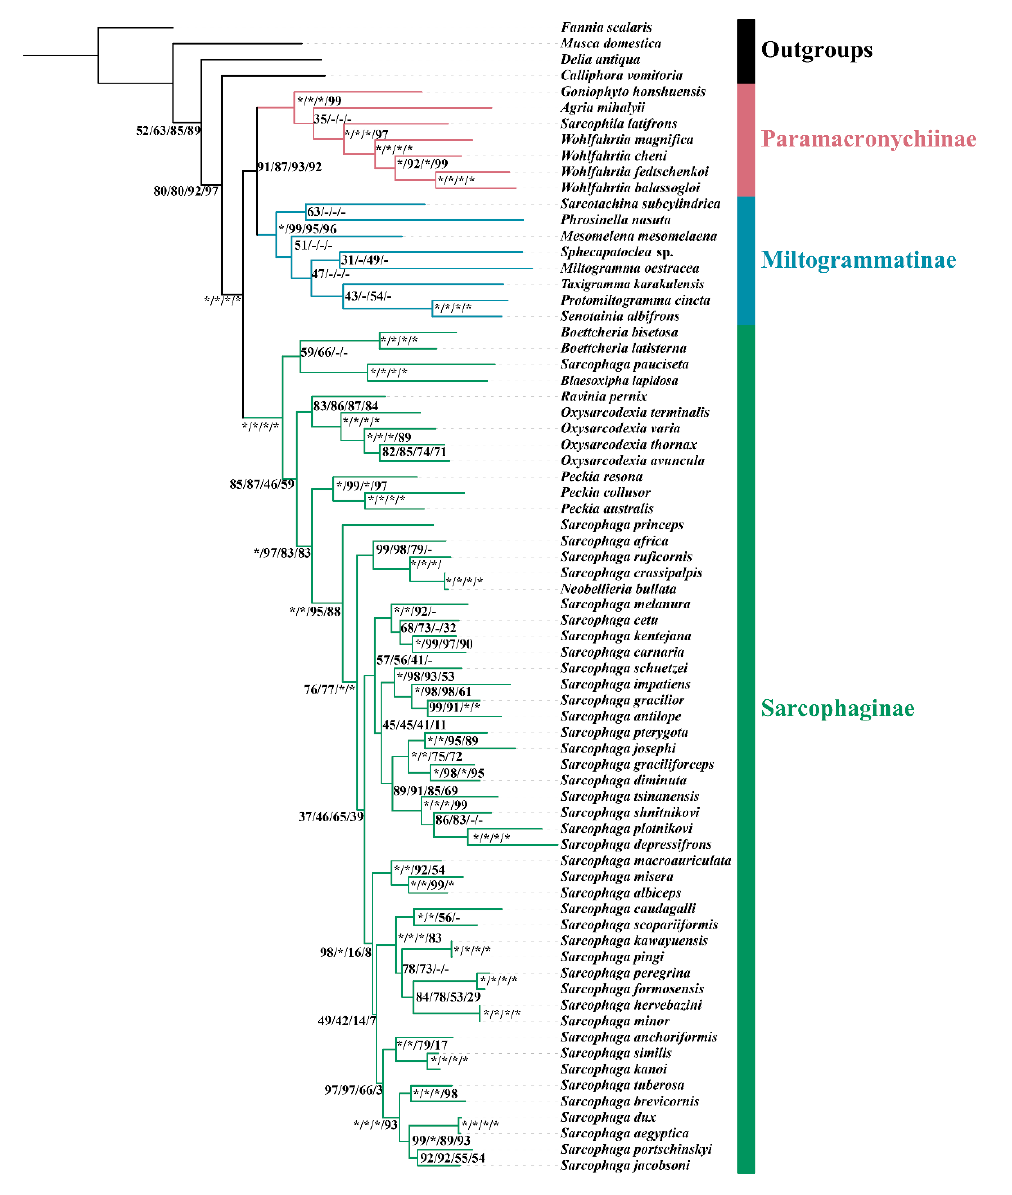
Figure 5. Maximum likelihood phylogenetic tree for Sarcophagidae based on concatenation of 13 mitochondrial protein-coding genes and 2 rRNA genes. Each node is provided with the support values of Maximum Likelihood bootstrap values (BS) for tree inference using matrix PCGsrRNA/PCGs/PCGs12rRNA/PCGs12. Asterisks (*) represent full support, while hyphens (-) indicate that the branch is not recovered.